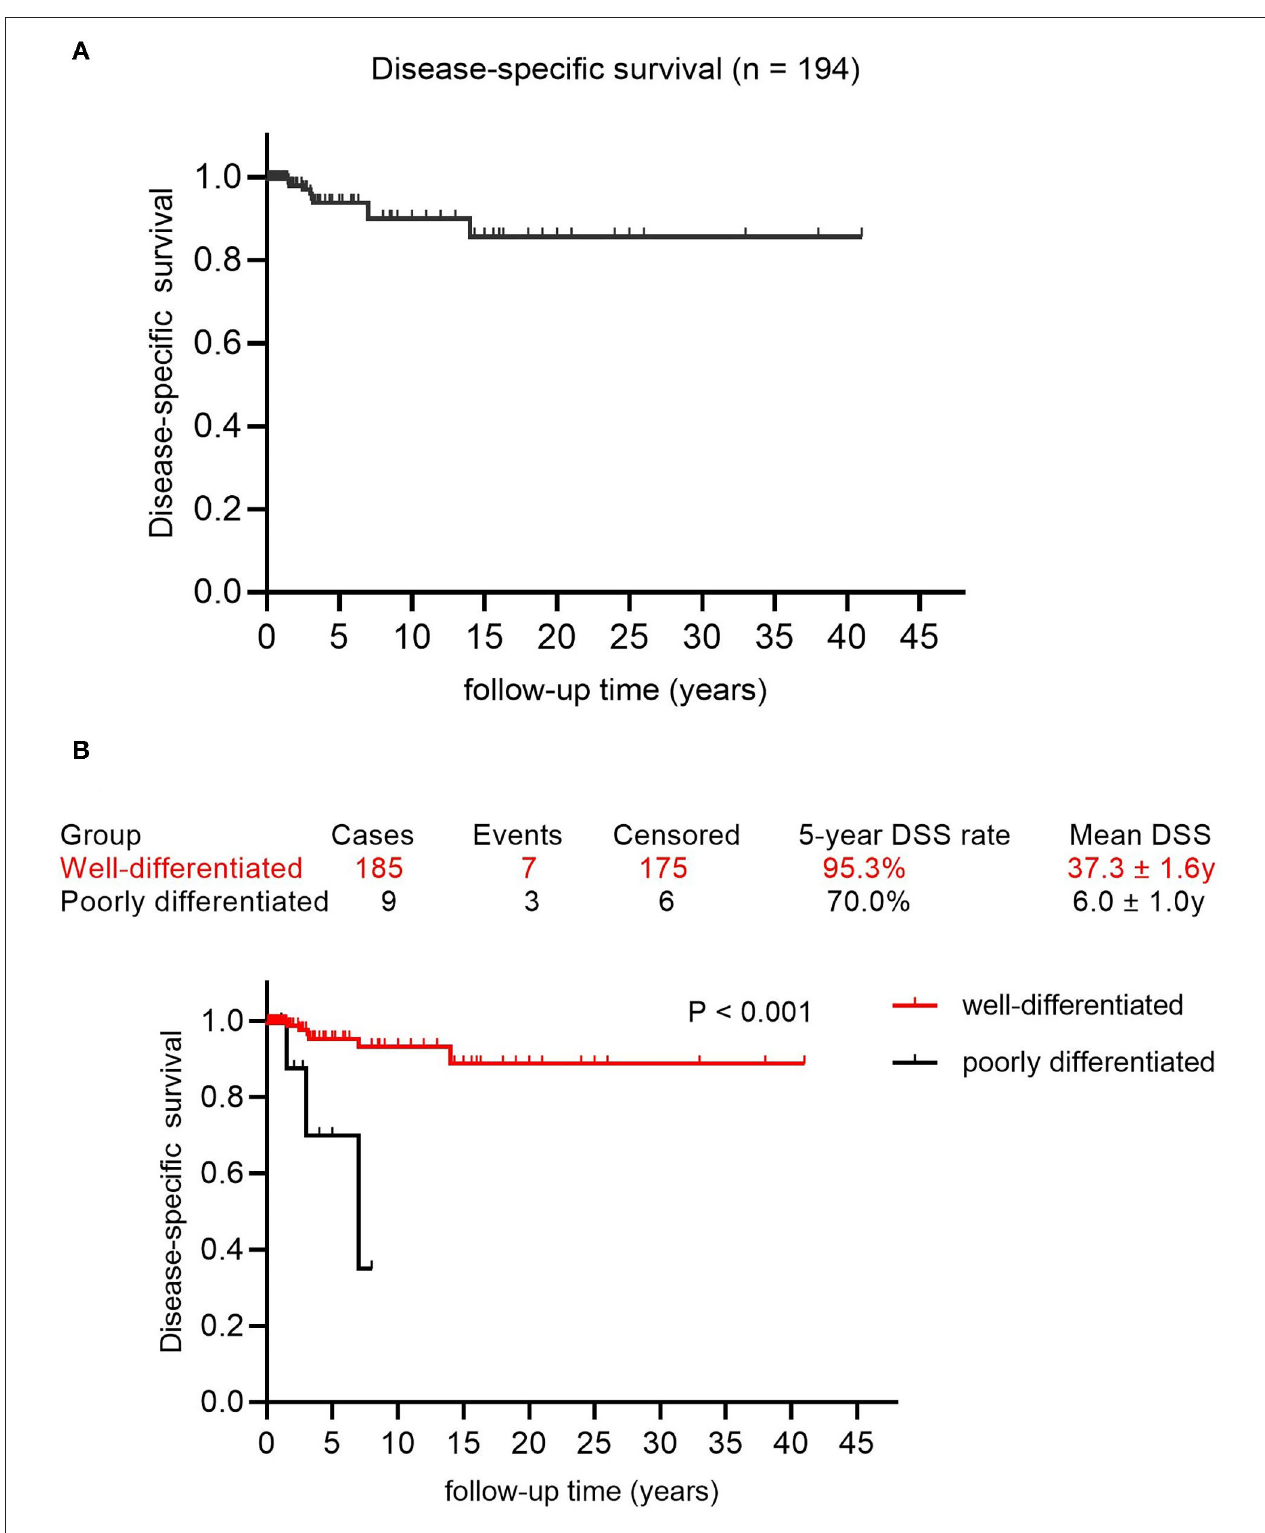
FIGURE 4 | The survival curves in patients with MSO. (A) Disease-specific survival in this cohort. (B) The Kaplan-Meier (log-rank) test demonstrated the significantly different DSS rate between patients with well-differentiated MSO and poorly differentiated MSO ( p < 0.001).